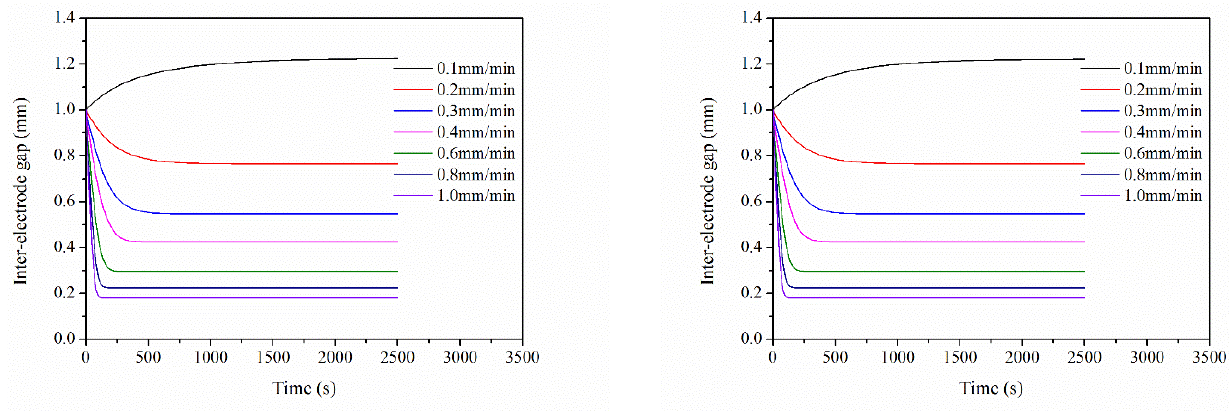
Figure 7. Diagrams of the inter-electrode gap evolutions.